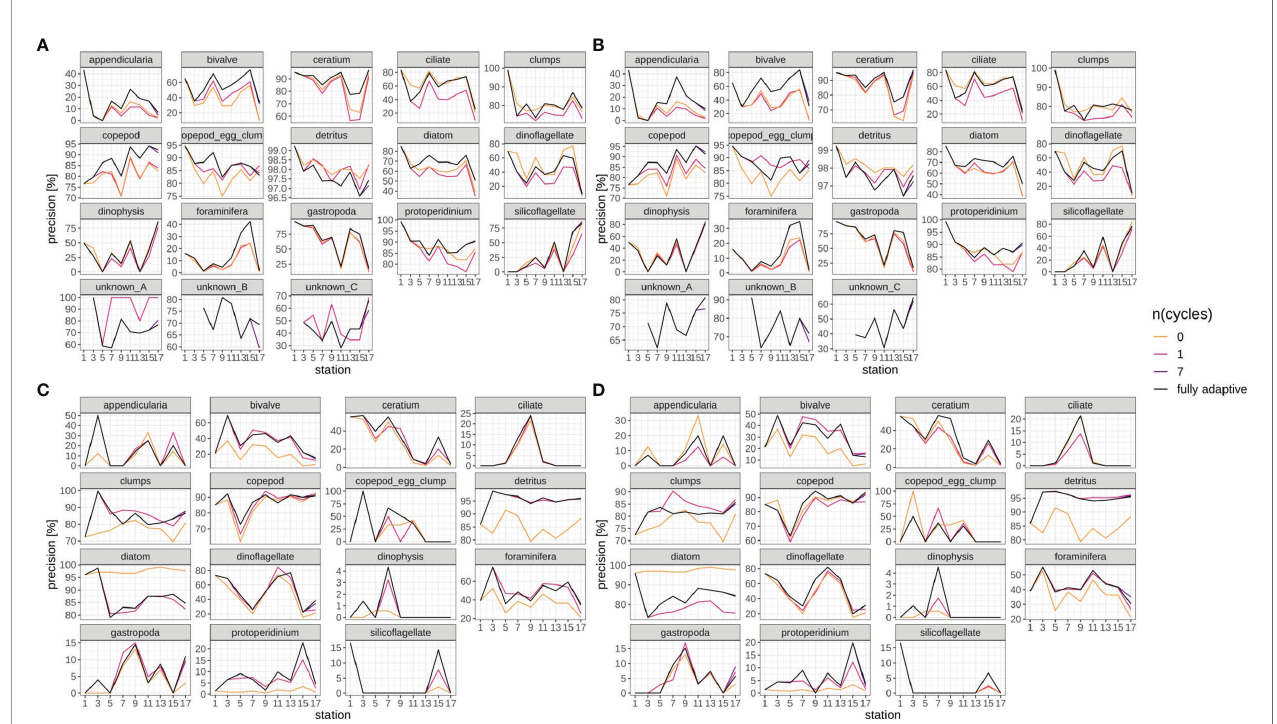
FIGURE 8 | Class-speci fi c precision trajectories. Black line represents fully adaptive DOC implementation (training-set update every second station); colored lines represent less-adaptive implementations (denoted by the number of adaptation cycles). (A) : September survey, fi rst replicate, (B) September survey, second replicate; (C) : December survey, fi rst replicate, (D) : December survey, second replicate. Replicates differ in the random selection of images for training-set updates and random parameter initializations of models before training (see Case Studies – North Sea Surveys ). Trajectories for all nine adaptation modes are shown in Figure SI XI/4